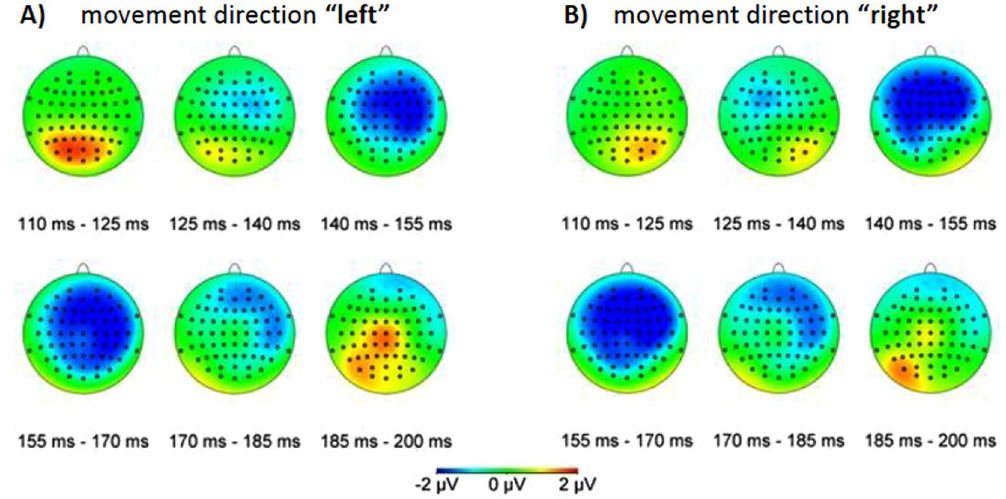
Figure 4. Difference between “complete trajectory, standard trials” and “half trajectory, appear” data. Each plot shows the ERPs averaged over 15 ms from trials in which subjects attended to the central target. Panel (A) shows data for stimuli presented in the left half of the visual field and panel (B) for stimuli presented in the right half of the visual